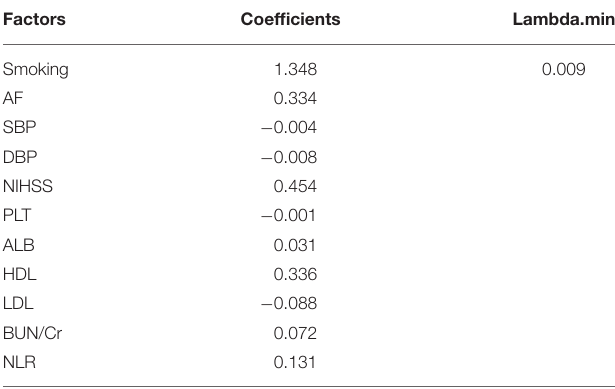
TABLE 2 | Coefficients and lambda.min value of the LASSO